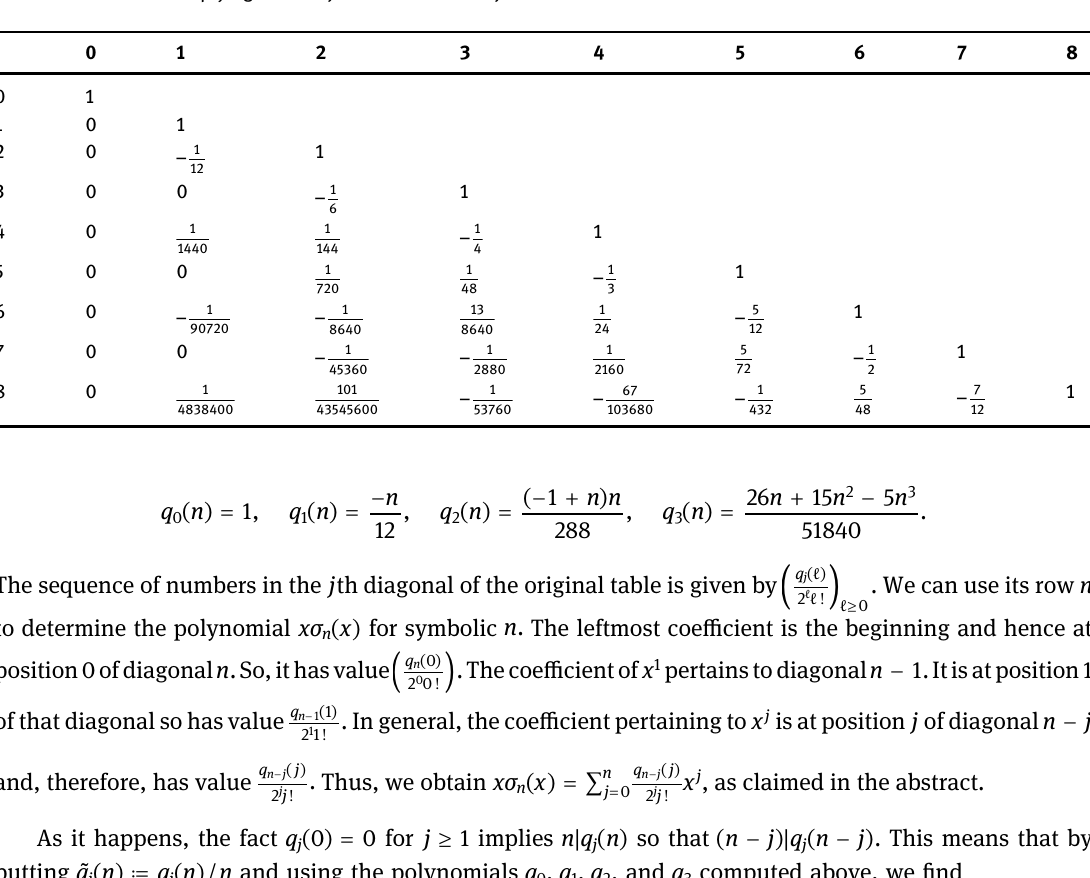
Table 2: Result of multiplying column j of Table 1 with 2 j j